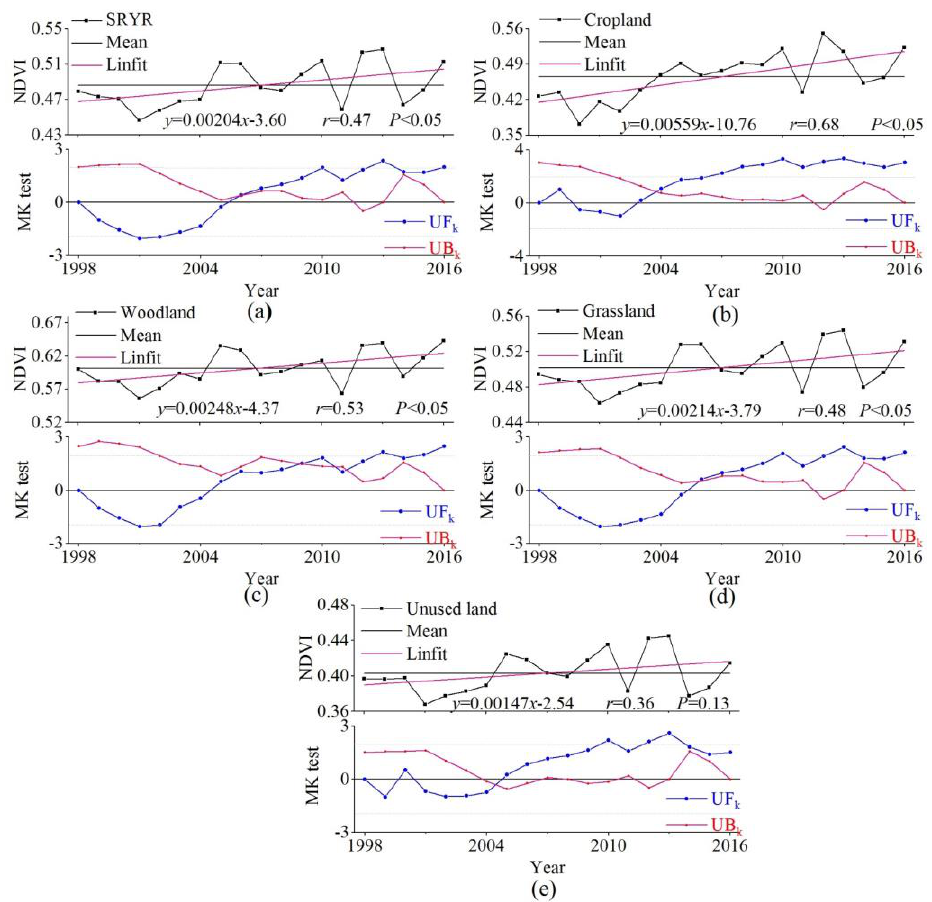
Figure 3. Temporal change of NDVI in different land-use types: ( a ) the SRYR; ( b ) cropland; ( c ) woodland; ( d ) grassland; ( e ) unused land.